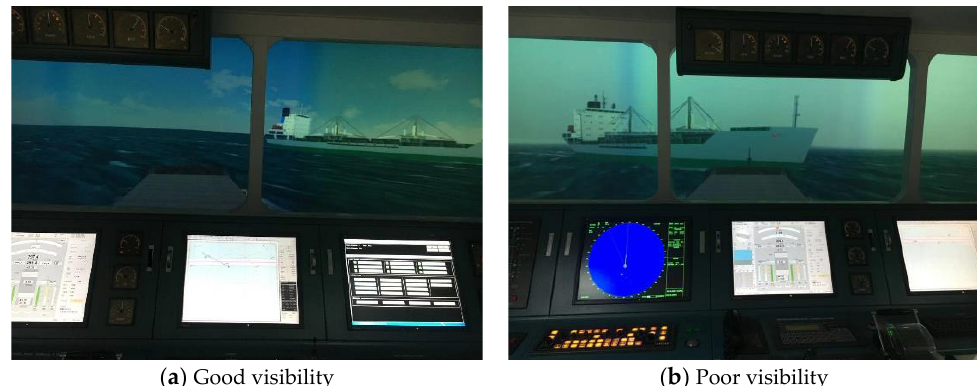
Figure 3. Experimental scenarios for visibility.